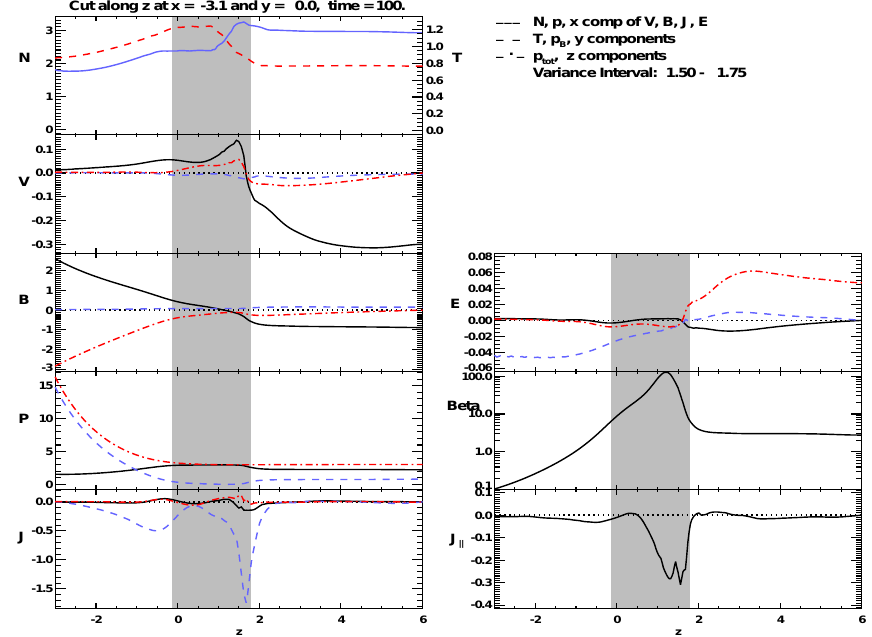
Fig. 5. Simulated data for a cut along z at (x,y) = ( − 3 . 1 , 0 ) . All quantities are plotted in normalized simulation units. Plotted in the left column from top to bottom are the density (solid blue line) and temperature (dashed red line), velocity components (x – solid black, y – dashed blue, z – dash-dot red), magnetic field components, pressure (thermal pressure – black, magnetic pressure – blue, total pressure – red), and current density components. The right column displays (from top to bottom) the electric field components, plasma β , and the parallel current density. The shading indicates regions of plasma β >